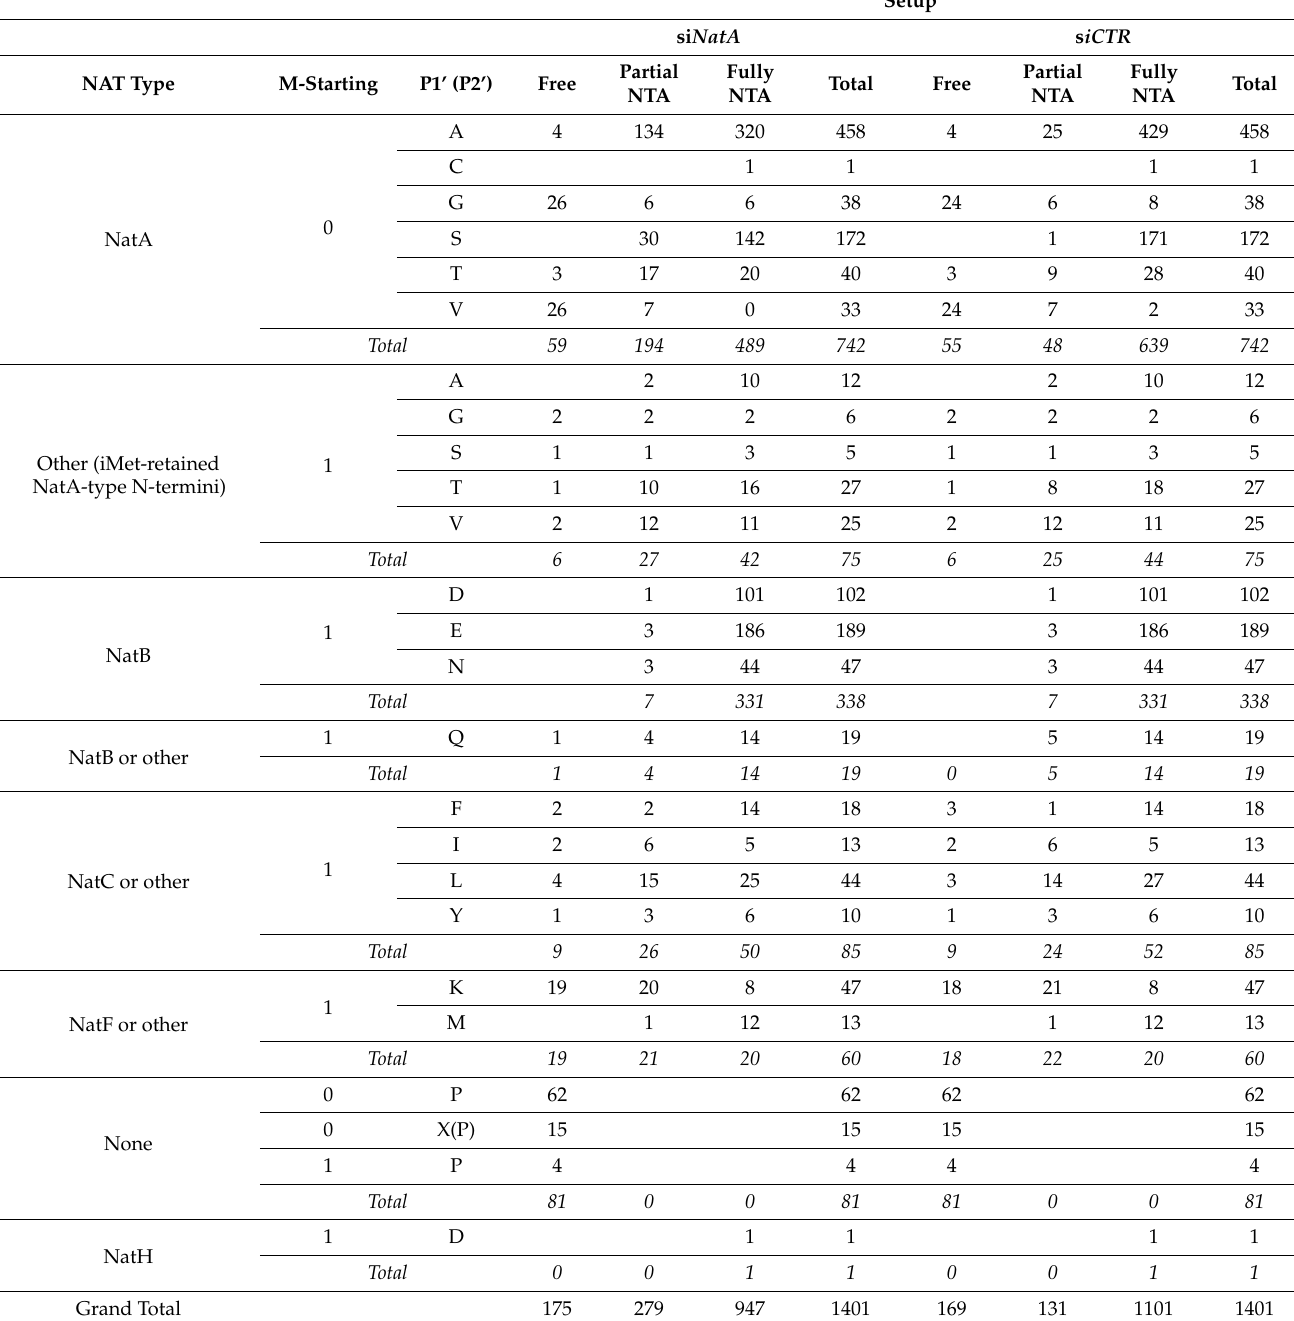
Table 2. Overview of the Nt-acetylation status of all identified protein N-termini. N-termini are categorized according to their NAT substrate class (with totals of substrate classes italicized) and the setup analyzed. Notable differences in NTA levels between the si CTR and si NatA setups were enriched in the NatA category of N-termini (See also Table 1 and Tables S1 and S2 for the complete list of all (affected) N-termini identified). Only N-termini of which the degree of NTA could be determined and which were compliant with the rules NTA and NME [46,49] were used for the overall calculation of